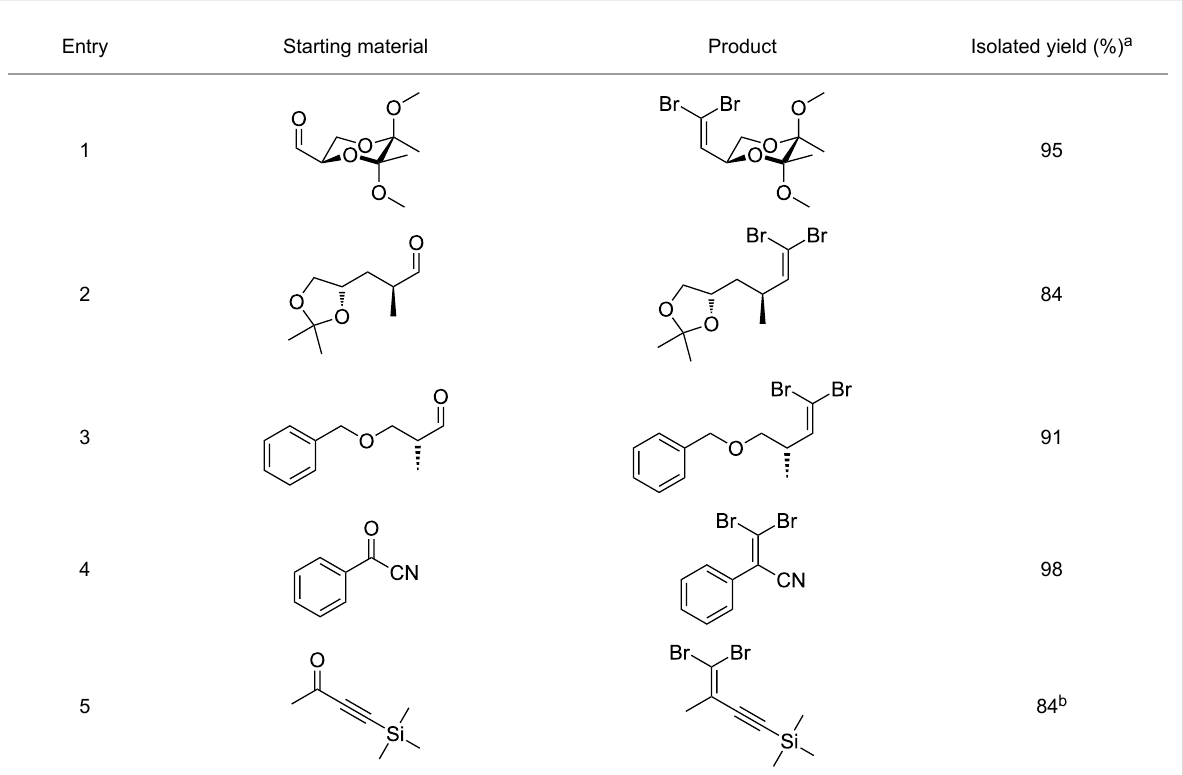
Table 2: α -Chiral aldehydes and ketones containing electron-withdrawing groups converted to the corresponding gem -dibromides using the triphenyl- phosphine monolith in